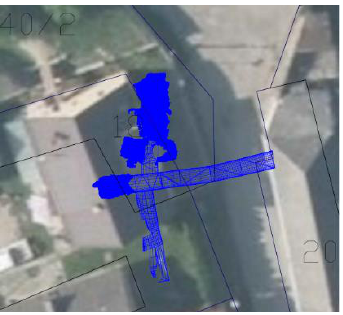
Figure 1. Cadastral map, orthophoto (COSMC, 2014) and geodetic survey of underground